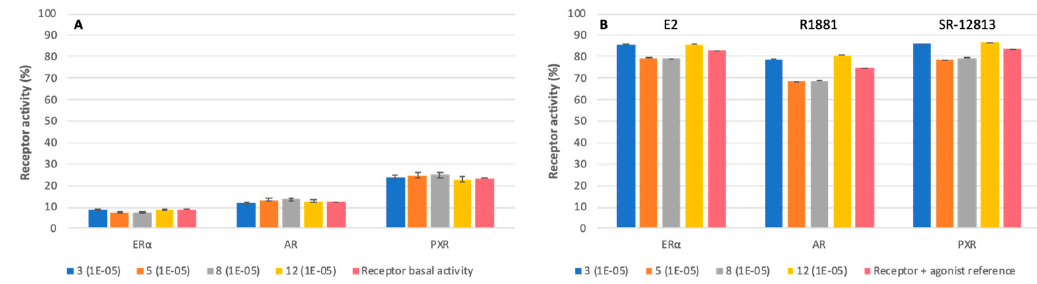
Figure 4. Receptor activities (%) of estrogen receptor α (ER α ), androgen receptor (AR), and pregnane X receptor (PXR) of synthesized molecules for agonist ( A ) and antagonist ( B ) interactions at 10 − 5 mol.L − 1 .